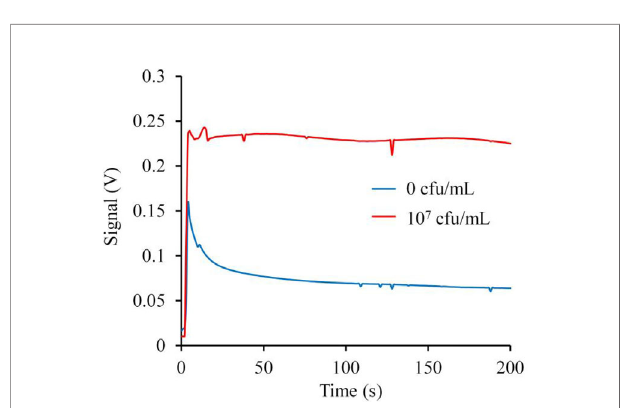
FIGURE 4 | The fl uorescence signal-time response trace and the optimal detection values applied in this study. The time response curve shows that the signal reached the maximum value instantly after the laser turning on and then decreased back gradually. After decreasing back, the fl uorescence signal gradually tended to be stable. The trace showed that the effective response interval could be de fi ned from 50 to 200 s and the average values of the fl uorescence signal of the effective time interval calculated by the computer could be the optimal detection values applied in this study. In addition, the results also showed that the signal response of the S. aureus at the 10 7 CFU/ml concentration was signi fi cantly higher than that of 0 CFU/mL and the biosensor might be used to distinguish S. aureus at different